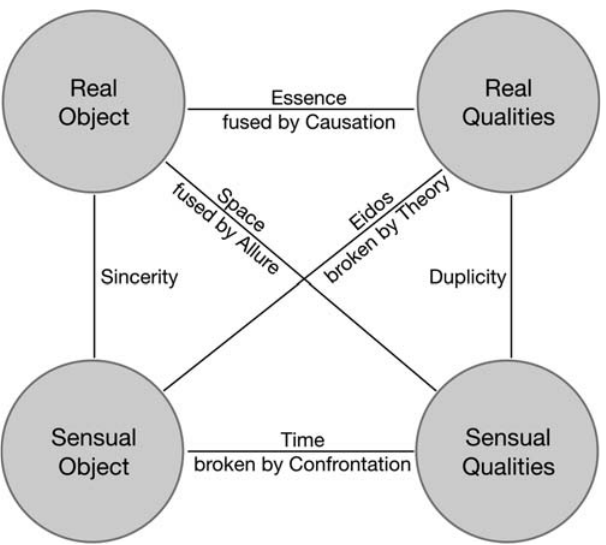
Figure 1: Harman ’ s fourfold Ontography, adapted from: Harman, The Quadruple Object , 114 – 115,